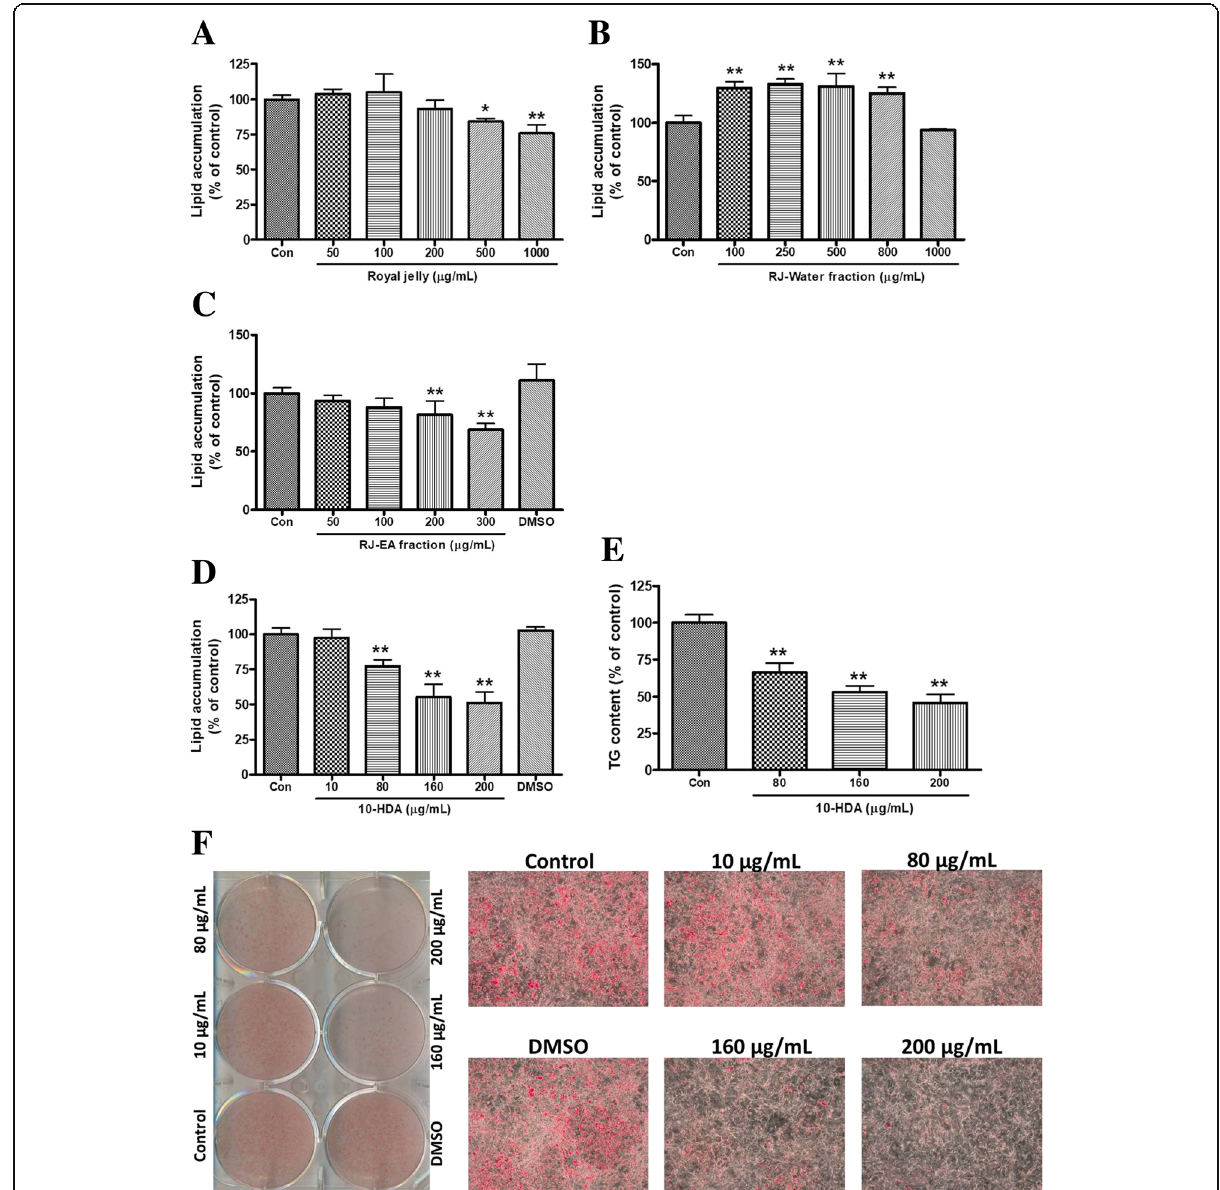
Fig. 3 Effect of ( a ) royal jelly (RJ), ( b ) royal jelly-water fraction, ( c ) royal jelly-ethyl acetate (RJ-EA) fraction, and ( d ) 10-HDA on relative lipid accumulation by 3 T3-L1 cells. The lipid accumulations (expressed as the percentage of control) are presented as means ± SD of four separate experiments. e The inhibition of TG content by 10-HDA on 3 T3-L1 cells are presented as means ± SD of triplicate experiments. f Visualization and high magnification (× 10) were conducted for the ORO stained lipid-containing cells which were treated with 10-HDA. Statistical significance was calculated using one-way ANOVA followed by Dunnett ’ s multiple comparisons test. * P < 0.05 vs control; ** P < 0.01vs